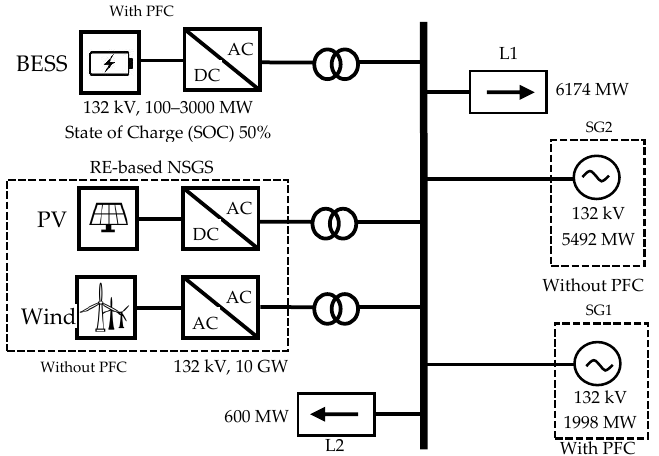
Figure 6. Power system model consisting of two SGs, BESS-inverter and an RE-based NSGS.